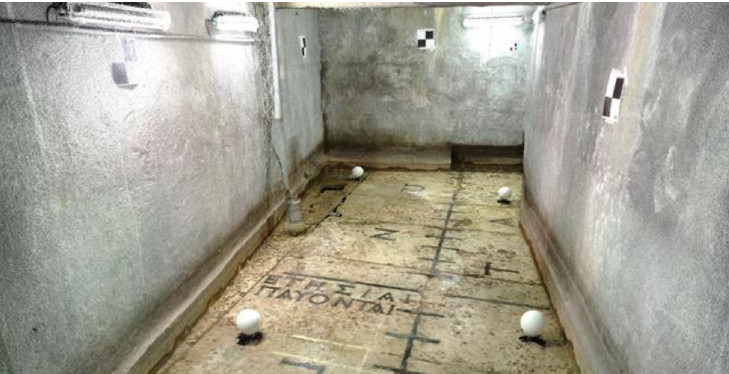
Figure 6. View of the point cloud in the sundial underground room.